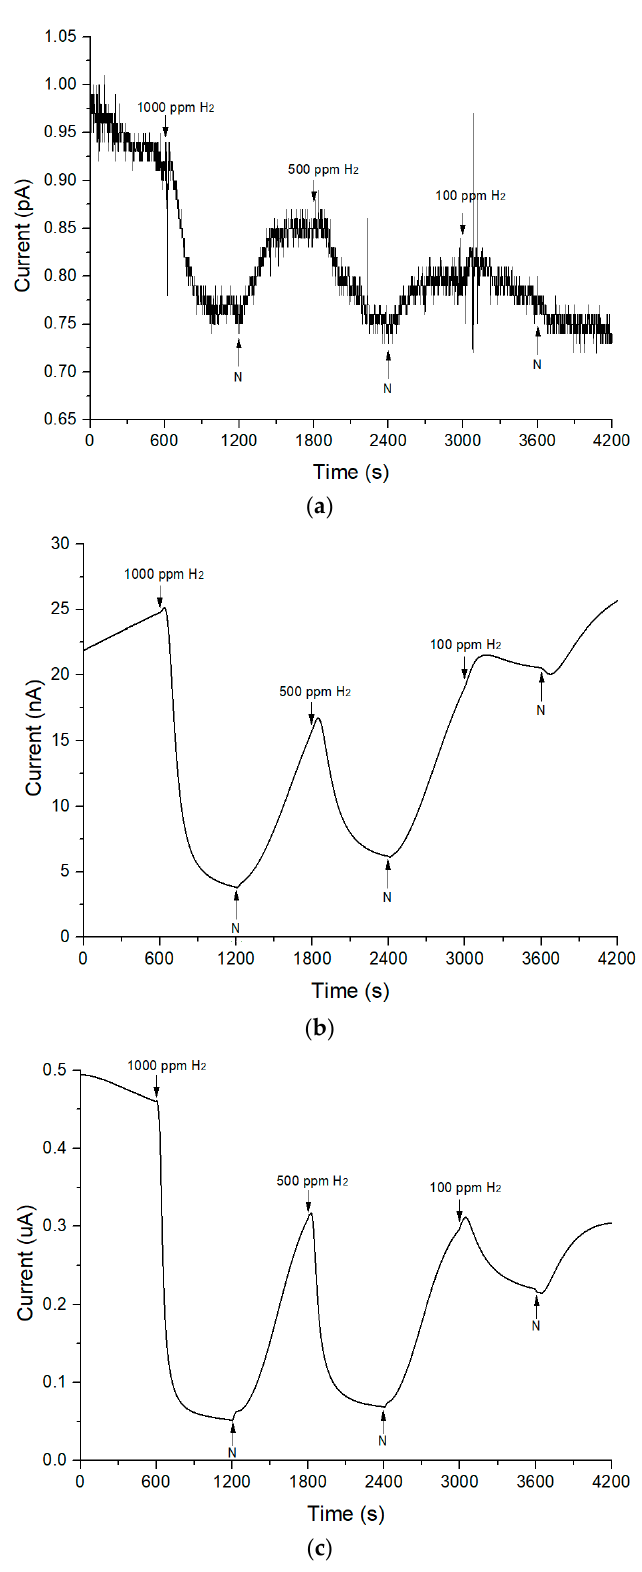
Figure 10. Response of TiO 2 -B 2 O 3 gas sensor to hydrogen at different operating temperature ( a ) T = 100 °C ( b ) T = 200 °C ( c ) T = 300 °C.